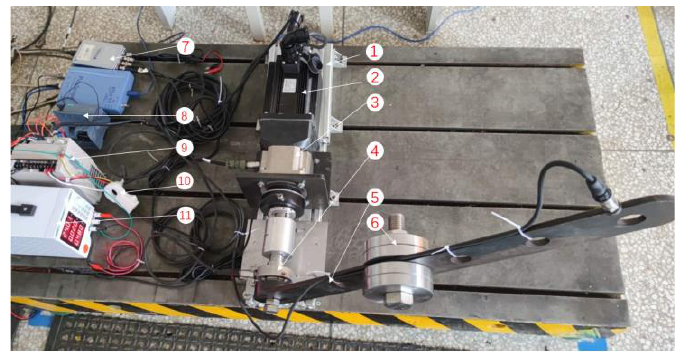
Figure 8. Swing arm test stand.